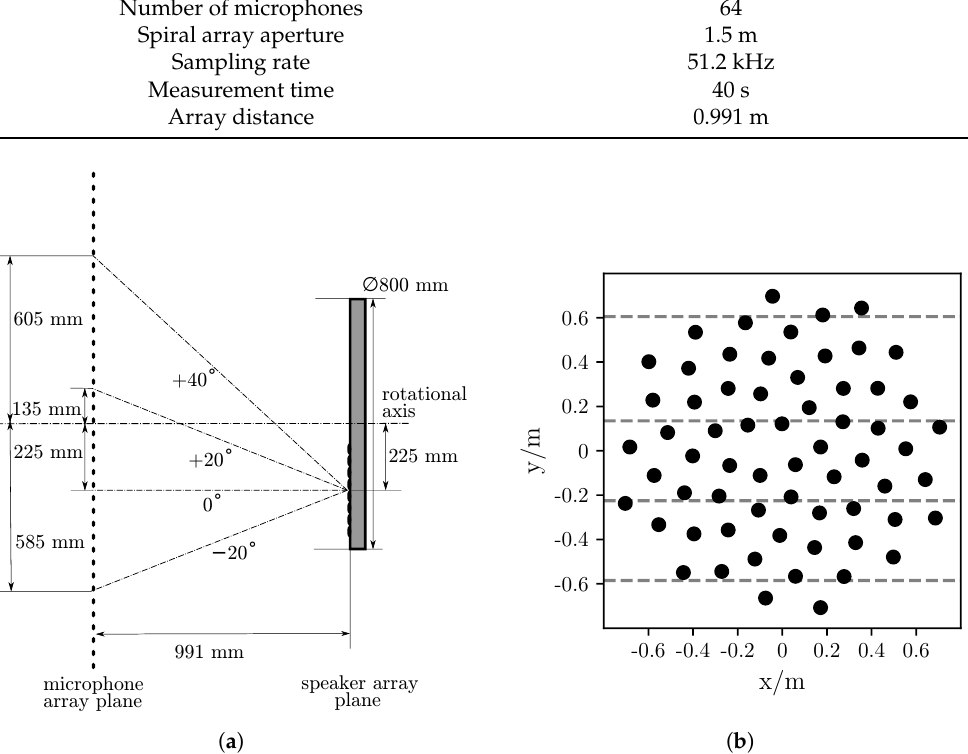
Figure 2. ( a ) The side view of the setup including the main lobe direction of the speaker array for each of the four steering angles; ( b ) the microphone arrangement in the array